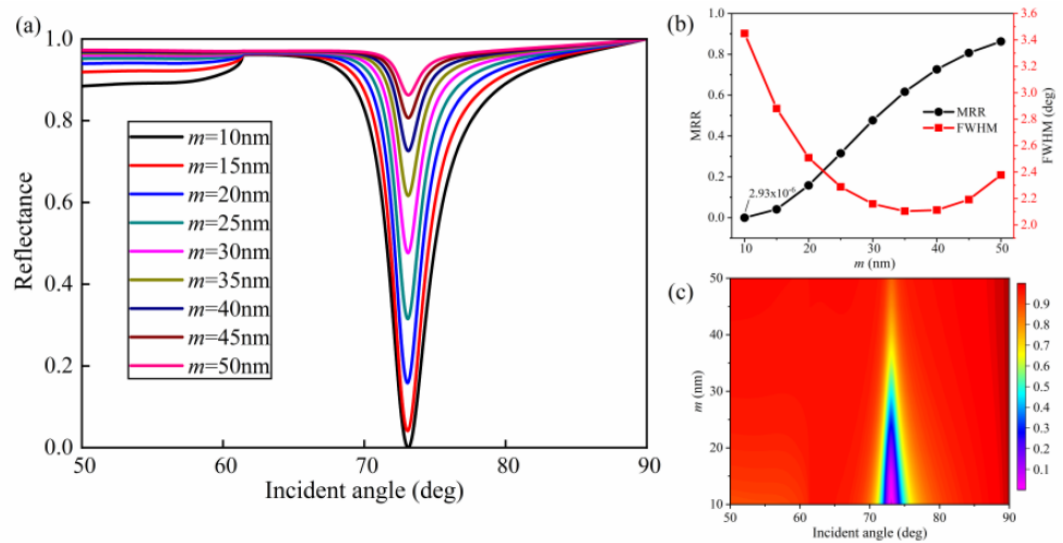
Figure 3. Influence of the lower silver film thickness ( m ) on reflectance: ( a ) SPR curves of various lower silver film thicknesses; ( b ) MRR and FWHM as a function of m ; ( c ) contour plot of the reflectance ( T = 15 nm, w = 50 nm, h = 50 nm, Λ = 100 nm, and L = 1).